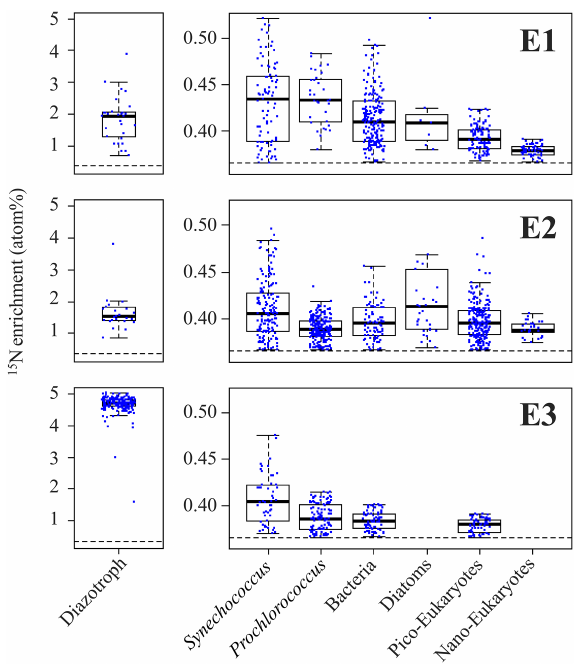
Figure 3. Left panels: boxplot of the 15 N enrichment measured in diazotrophs ( Trichodesmium for E1 and E2, and UCYN-B for E3). Right panels: 15 N enrichment measured in non-diazotrophic plank- ton: Synechococcus , Prochlorococcus , bacteria, diatoms, pico- eukaryotes and nano-eukaryotes for each experiment. The black dotted line indicates the natural isotopic enrichment.